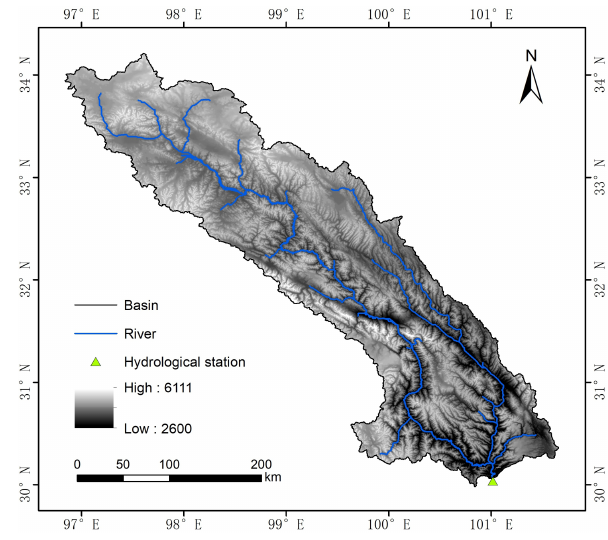
Figure 1. Topography, river networks, and streamflow gauging sta- tion of the